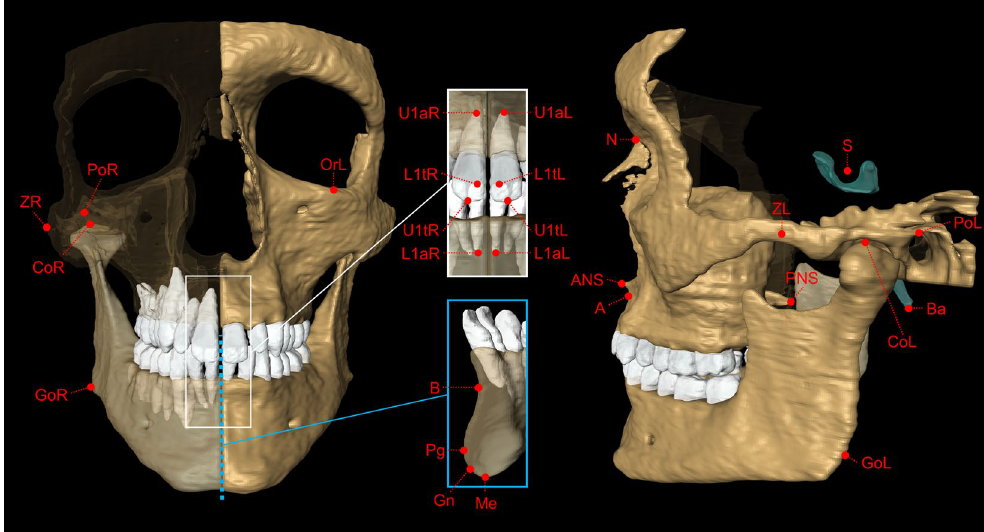
Figure 4. Cephalometric landmarks used in the present study. For each MRI dataset, 27 cephalometric landmarks were determined on multiplanar images. The 3D skull segmentation shown in this figure was generated from 3D MRI of volunteer #2 using Amira software (Version 6.4.0, Thermo Fisher Scientific, MA, USA). Definitions of cephalometric landmarks: N = Nasion (most anterior point of the frontonasal suture); S = Sella (geometric center of the pituitary fossa); Ba = Basion (lowest point on the anterior border of the foramen magnum); CoL/CoR = left/right Condylion (most superior point of Condyle); GoL/GoR = Left/right Gonion (midpoint on the curvature of the angle of the mandible); PoL/PoR = Left/right Porion (Most superior point of the external auditory meatus); OrL = Left Orbitale (most inferior point on the infraorbital margin); ZL/ ZR = Left/right Zygion (Most lateral point of the zygomatic arch); ANS = Anterior nasal spine; PNS = Posterior nasal spine; A = Point A (point of maximum midline concavity on the maxilla); B = Point B (point of maximum midline concavity on the mandibular symphysis); Pg = Pogonion (most anterior point of mandibular symphysis); Me = Menton (most inferior point of mandibular symphysis); Gn = Gnathion (Midpoint between Pg and Me); U1tL/U1tR = Tip of the crown of the left/right first upper incisor; U1aL/U1aR = Apex of the left/ right first upper incisor; L1tL/L1tR = Tip of the crown of the left/right first lower incisor; L1aL/L1aR = Apex of the left/right first lower incisor; Definitions of planes: N_ANS_PNS = Midsagittal plane defined by the landmarks N, ANS and PNS; PoL_PoR_OrL = Frankfort horizontal plane defined by the landmarks PoL, PoR and